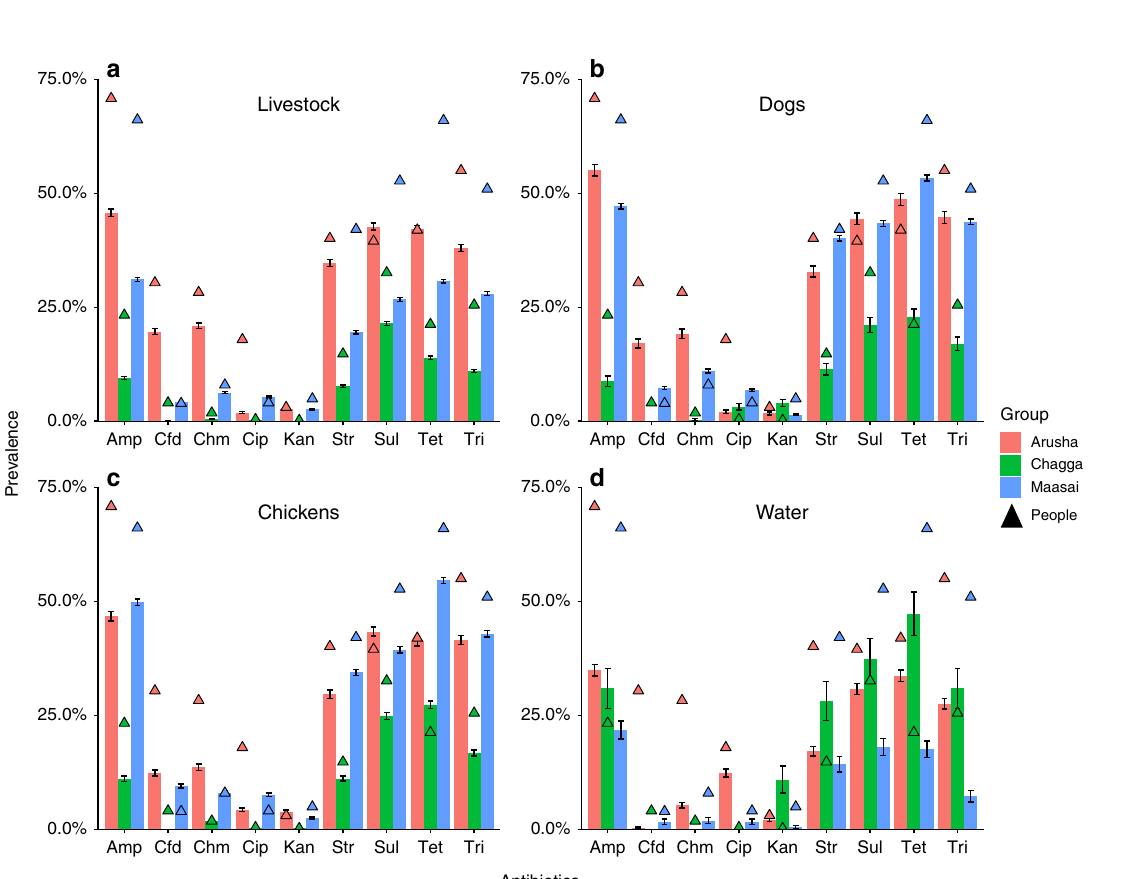
Fig. 2 Prevalence of antimicrobial resistant bacteria in people, animals, and water. Bacteria isolated from fecal samples collected from Maasai, Arusha, and Chagga people ( n = 11,287 isolates) and animals ( n = 43,691 isolates) and water samples ( n = 1934 isolates). Antibiotics included amp (a mpicillin), cfd (ceftazidime), chm (chloramphenicol), cip (cipro fl oxacin), and kan (kanamycin), str (streptomycin), sul (sulfamethoxazole), tet (tetracycline), tri (trimethoprim). Error bars are 95% standard